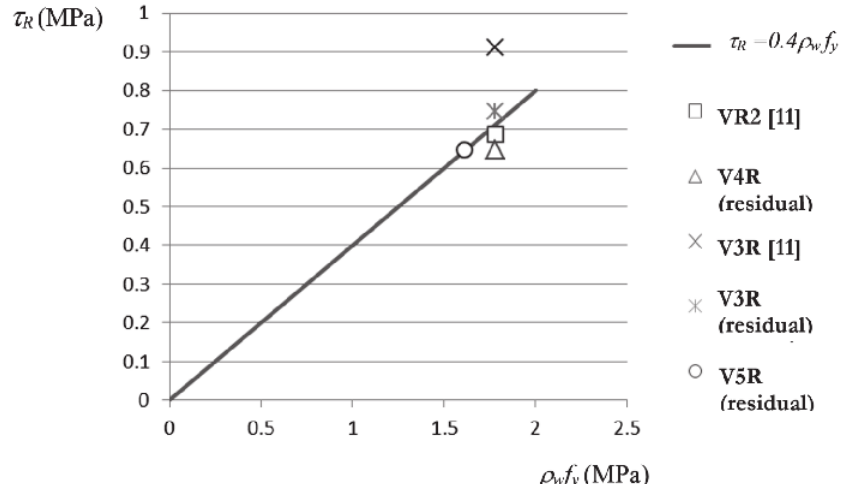
Relationship between t [11] and the residual shear stress of V4R, V3R and V5R